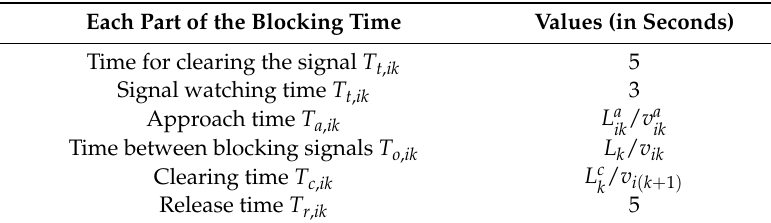
Table 6. Values of the six parts of the blocking time.